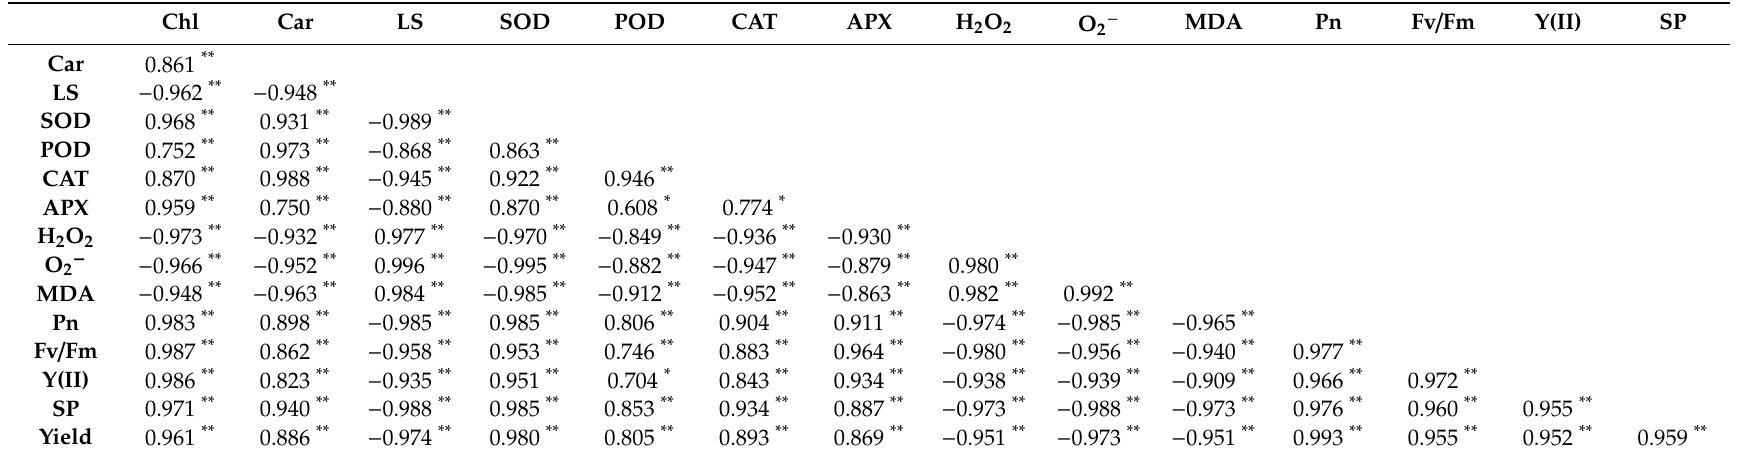
Chl, chlorophyll; Car, carotenoid; LS, leaf senescence rate; SOD, superoxide dismutase; POD, peroxidase; CAT, catalase; APX, ascorbate peroxidase; H 2 O 2 , hydrogen peroxide; O 2 − , superoxide radical; MDA, malondialdehyde; Pn, net photosynthetic rate; Fv / Fm, maximum quantum e ffi ciency of PSII; Y(II), actual quantum yield of PSII; SP, soluble protein. ** Correlation is significant at the 0.01 level; * correlation is significant at the 0.05